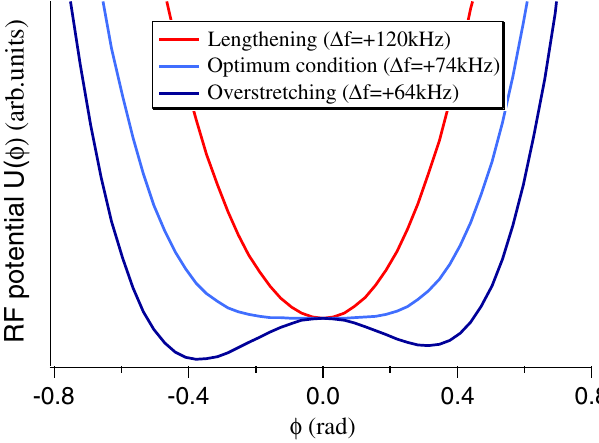
FIG. 14. (Color) Potential well distortion in lengthening mode, at optimum condition (flattened) and in overstretching regime, (cid:1) 315 mA by using formula calculated for I beam